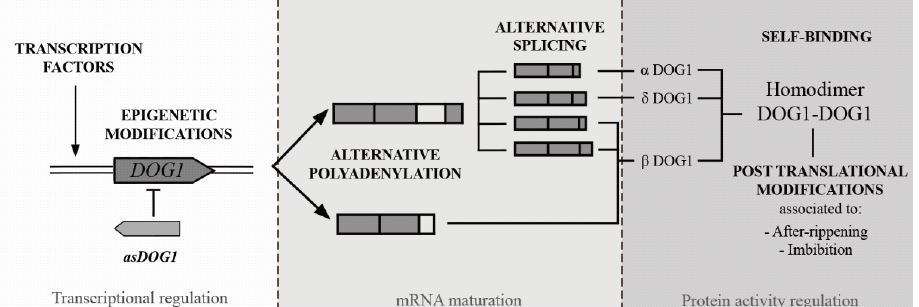
Figure 2. Di ff erent molecular mechanisms regulating the gene expression and protein activity of DOG1. The transcription of DOG1 is regulated by epigenetic modifications and probably by TFs. Additionally, the transcription of a noncoding antisense sequence (asDOG1) acts as a negative regulator of DOG1 expression. Two di ff erent precursor mRNAs are formed due to the existence of two polyadenylation sites in Arabidopsis. The precursor mRNAs are processed to five di ff erent mature mRNA by alternative splicing and lately translated to three di ff erent protein isoforms (three of the five mRNA encode the same protein isoform). DOG1 binds itself to form homodimers and can su ff er post-translational modifications associated to AR and germination processes. However, the specific nature of these modifications is still unknown.